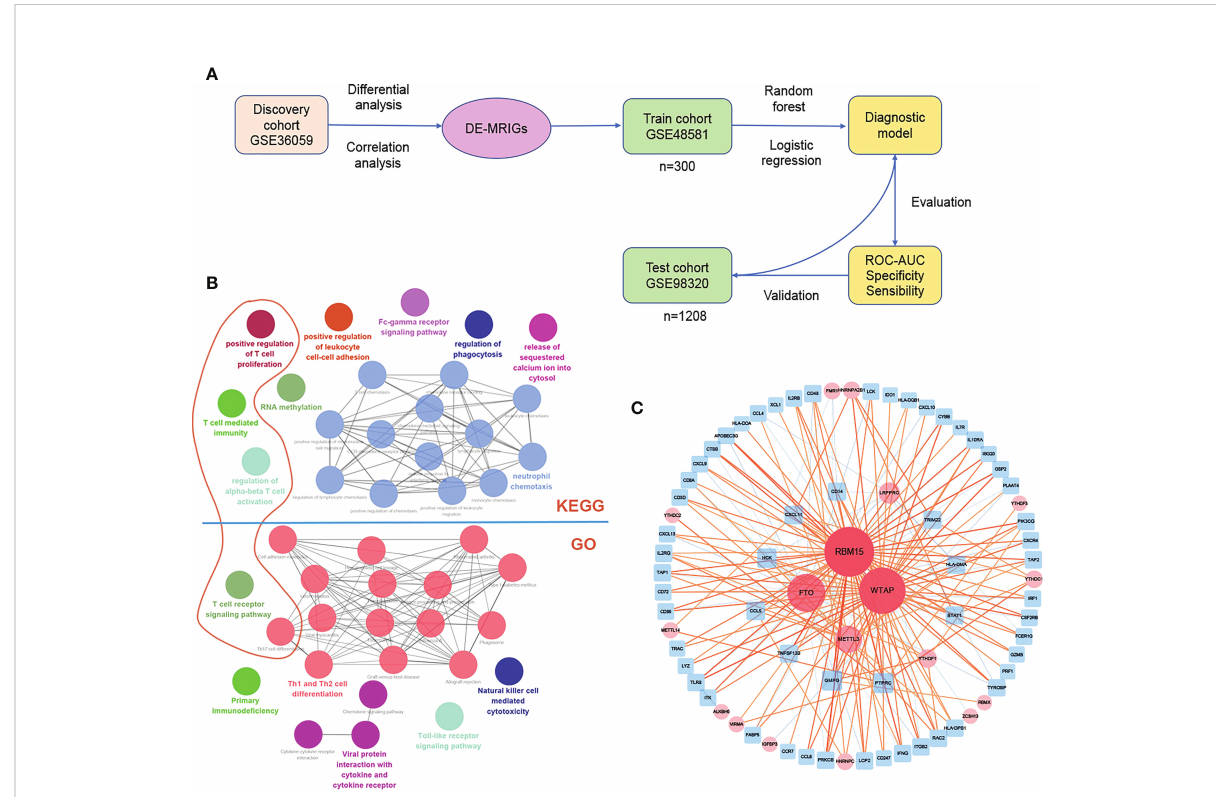
FIGURE 5 Construction and veri fi cation of diagnostic prediction model. (A) Flow of constructing the diagnostic prediction model. (B) Gene enrichment analysis and (C) network of DE-MRIGs and corresponding m6A regulators. DE-MRIGs, different expression m6A-related immune